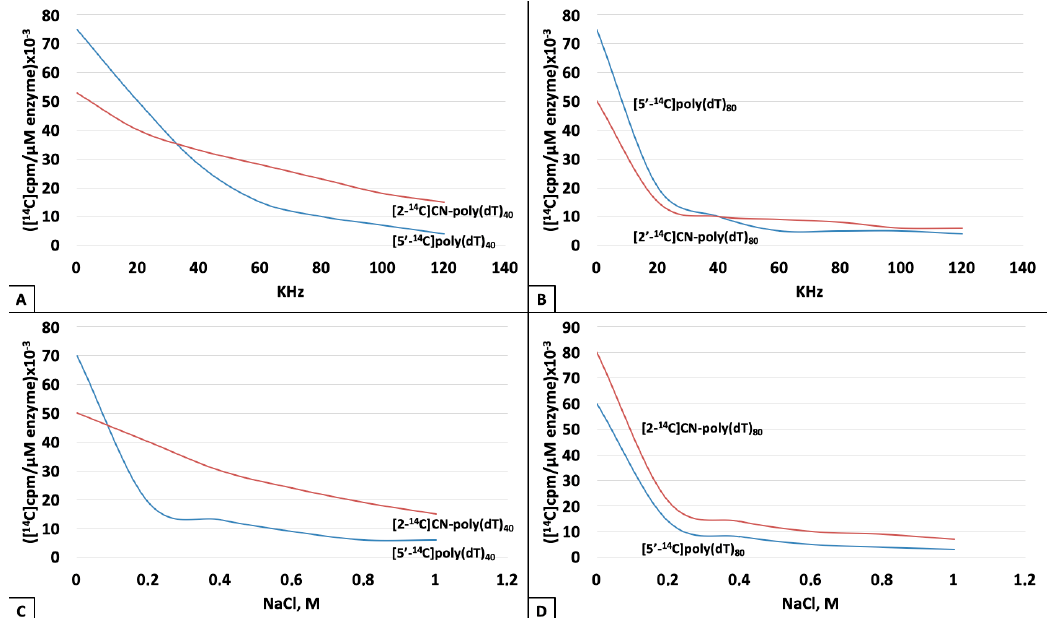
Figure 6. ( A ) A sonication affected stability of the couples of HL-60 beta-like DNA polymerase and 14 C-labeled Poly(CN-dT) 40 evaluated by detection of free ligand release. For technical details, see Methods . ( B ) A sonication affected stability of the couples of HL-60 beta-like DNA polymerase and 14 C-labeled Poly(CN-dT) 80 evaluated by detection of free ligand release. For technical details, see Methods. ( C ) A salt-caused decay of the unstable complexes between HL-60 beta-like DNA polymerase and 14 C-labeled Poly(CN-dT) 40 evaluated by detection of free ligand release. For technical details, see Methods . ( D ) A salt-caused decay of the unstable complexes between HL-60 beta-like DNA polymerase and 14 C-labeled Poly(CN-dT) 80 evaluated by detection of free ligand release. For technical details, see Methods .